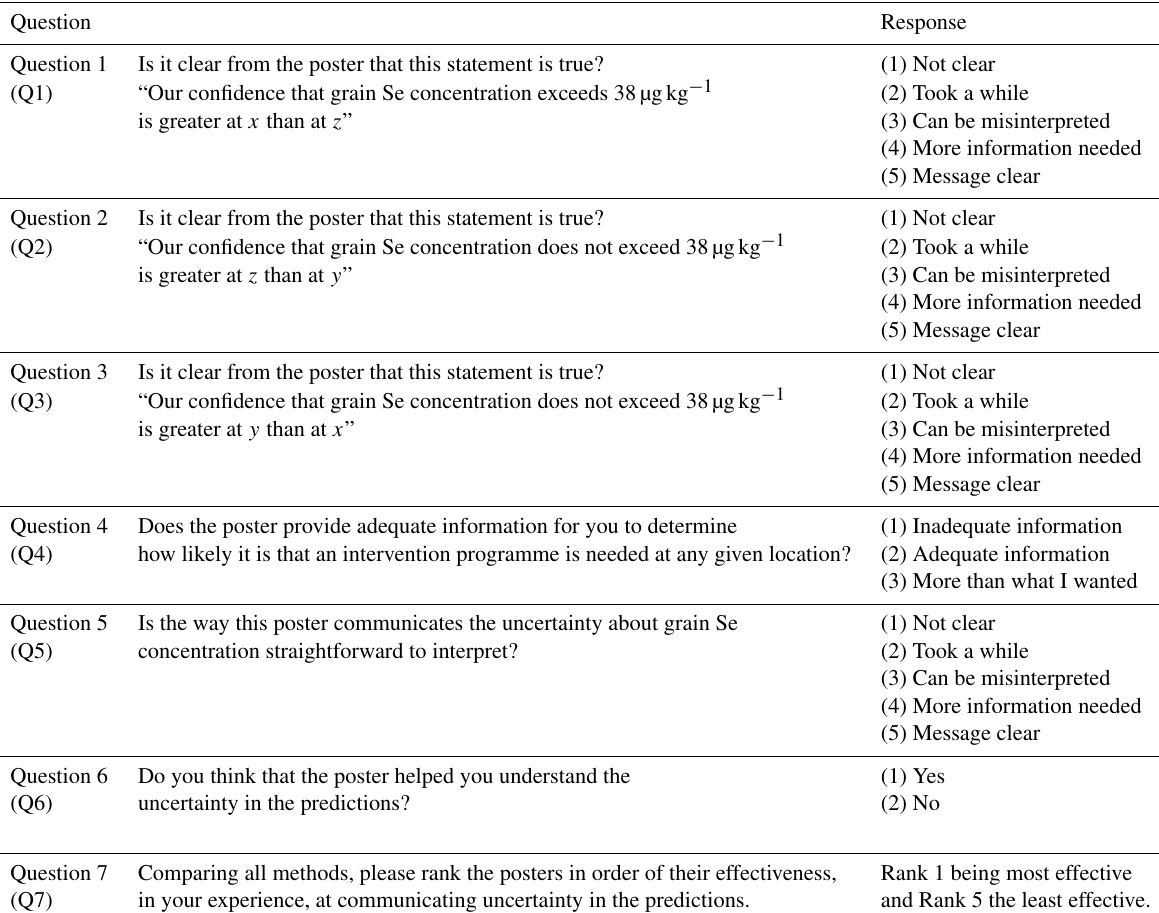
Table 3. The list of questions used to elicit stakeholder opinions about the usefulness of the communication methods presented as posters in the workshops in Ethiopia and